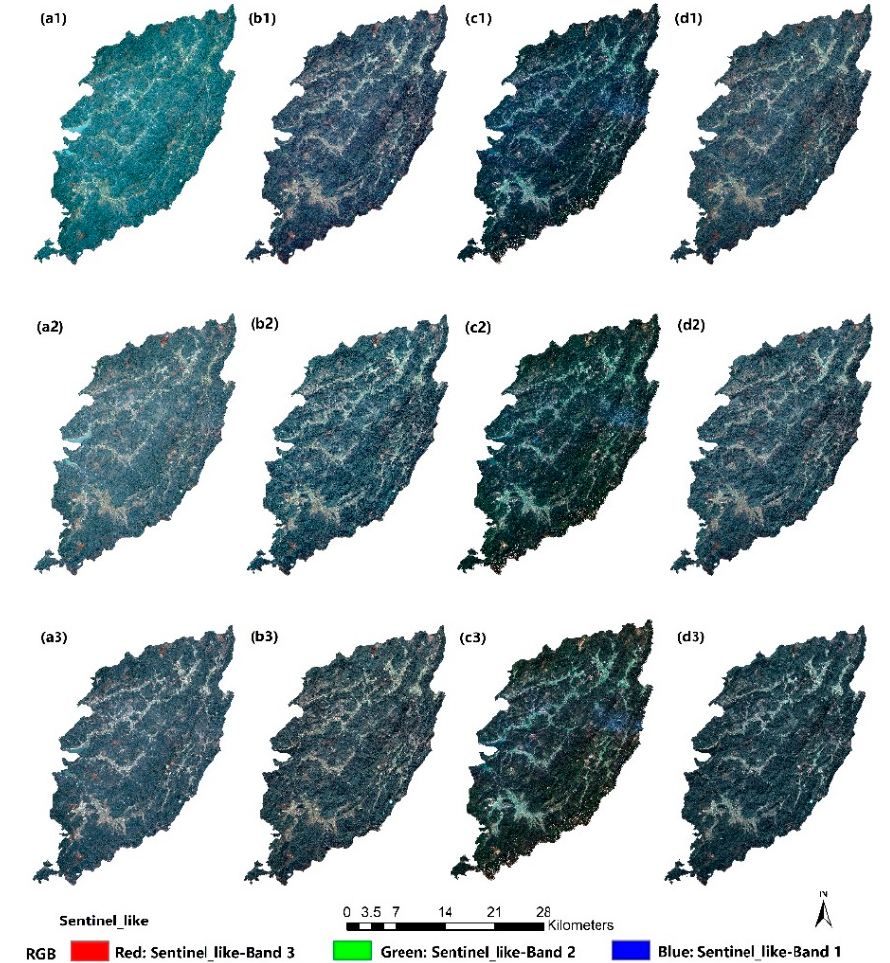
Figure 4. Sentinel-like images obtained by fusing Sentinel-2 image with the GF-2 images (B1_blue, B2_green and B3_red) using the GS, NND, WRM, and BT methods. ( a1 – a3 ) GS_B1, GS_B2, GS_B3; ( b1 – b3 ) NND_B1, NND_B2, NND_B3; ( c1 – c3 ) WRM_B1, WRM_B2, WRM_B3; ( d1 – d3 ) BT_B1,